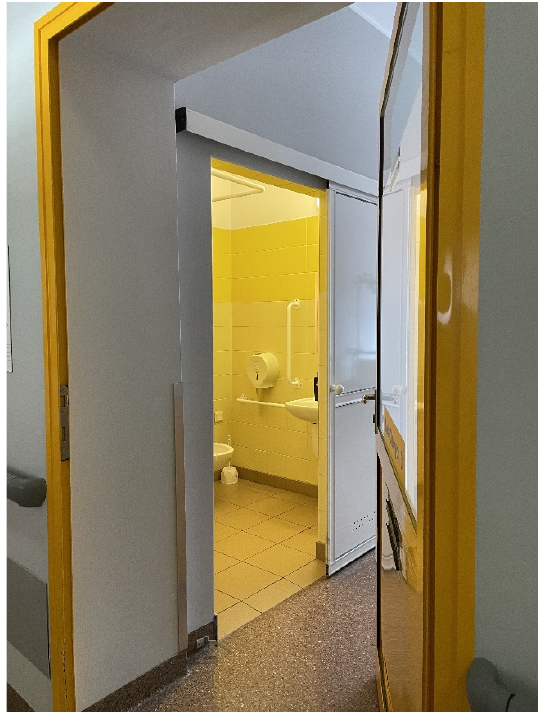
Figure 6 . Orthopaedic hospital in Poznan, source: author’s own material . Figure 6. Orthopaedic hospital in Poznan, source: author’s own